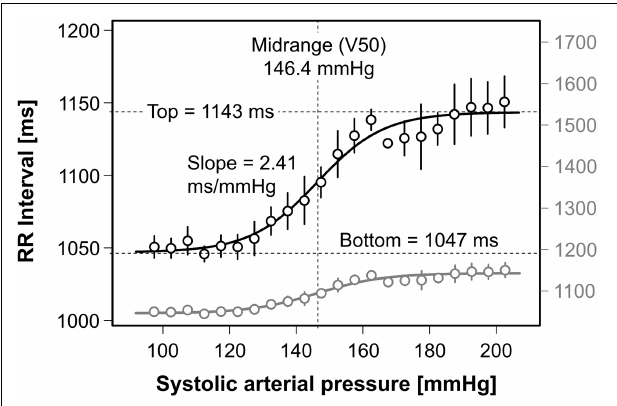
FIGURE 5 | Cardiac baroreflex curve in dysautonomia with marked reductions in response range and baroreflex sensitivity. Sigmoidal curve fitting using Equation 8 has been applied to real data from a patient with dysautonomia. The lower representation of the same data and fitting curve (gray) allows for visual comparison between healthy and diseased subjects because the resolution of the related ordinate on the right (gray) is similar to that in Figure 4 . Note the marked reduction in response range ( < 100 ms) and baroreflex gain (2.41